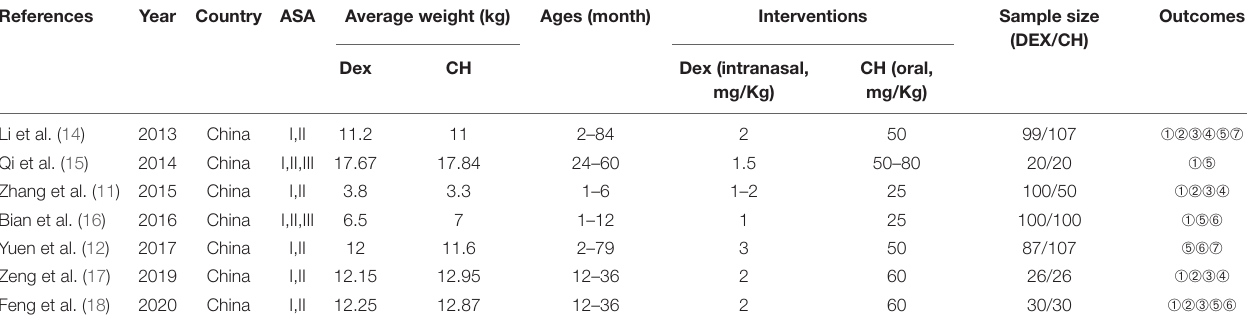
TABLE 1 | Basic characteristics of the included